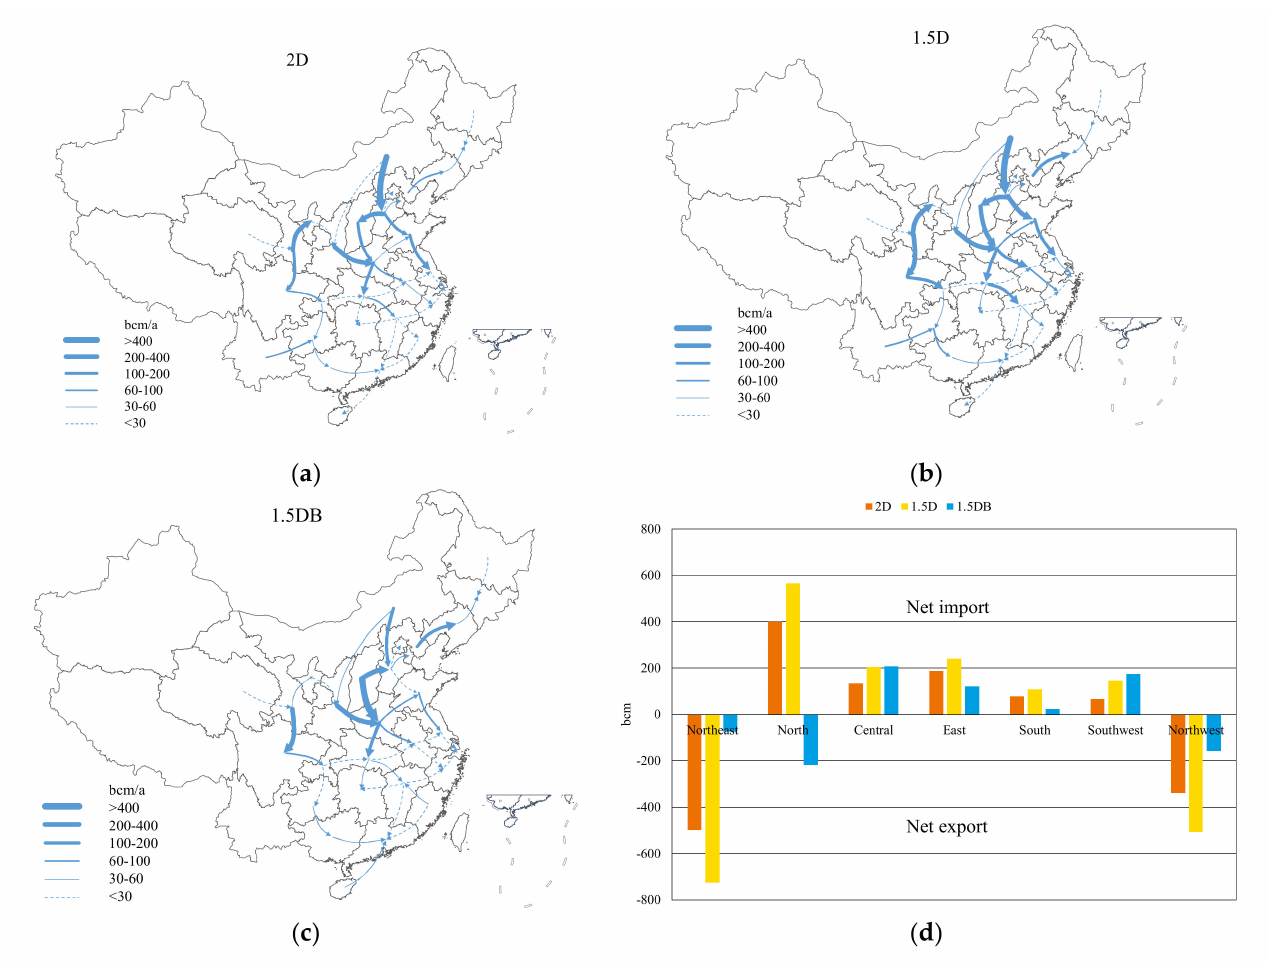
nario. Key indicators of hydrogen system planning are shown in Table 8. Hydrogen flows amongst all regions are shown in Figure 5.